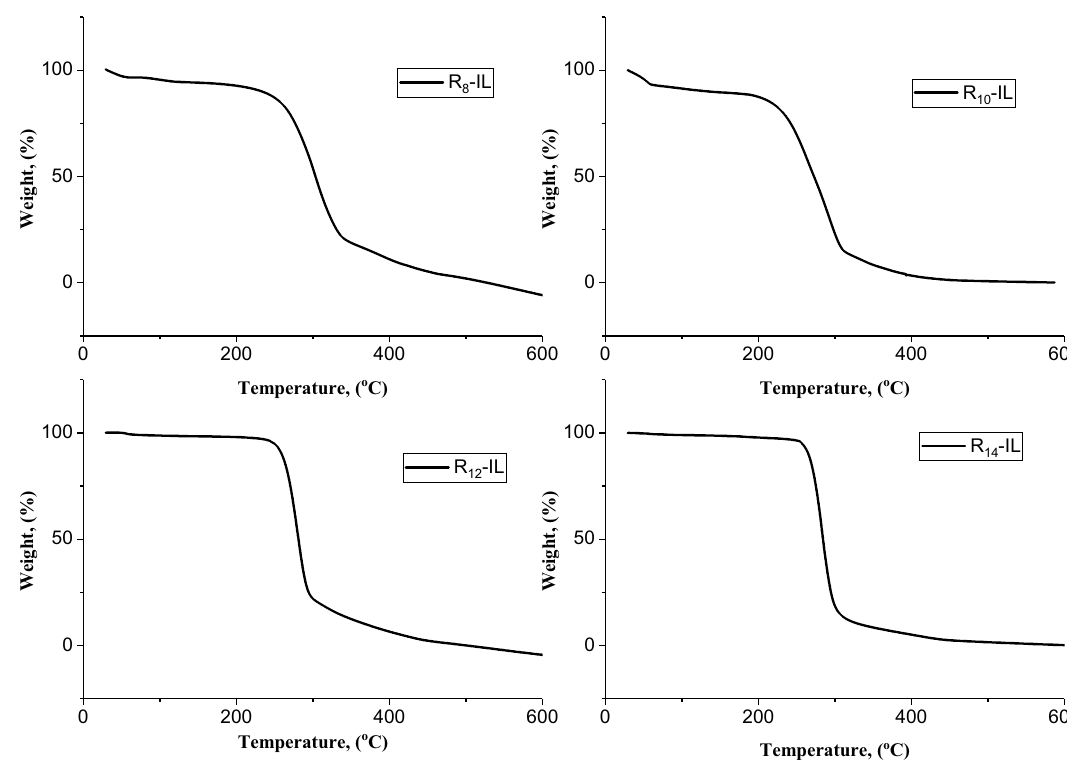
Figure 3. TGA thermograms of the synthesized ionic